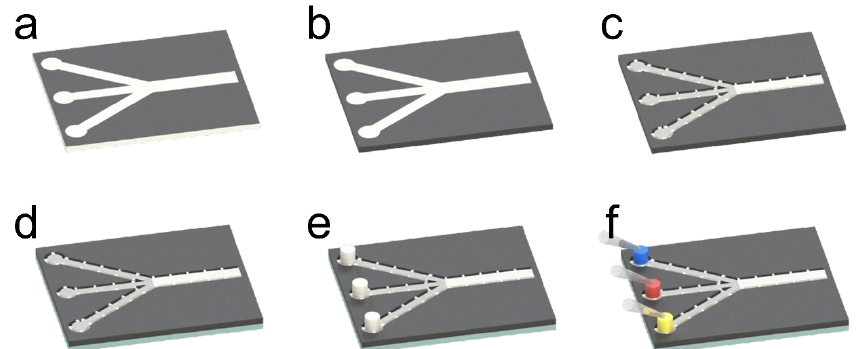
Figure A3. Fabrication process flow for demonstration device. ( a ) A wax layer defining the channels was printed using a solid wax printer onto Whatman #1 chromatography paper. ( b ) The wax was melted by placing the paper into an oven at 170 °C for 2 min. ( c ) The paper was etched and the channels were cut to final dimensions. The presence of the side-struts along the edge of the channels are for support, preventing the wet channels from buckling and lifting up from their backing. ( d ) The bottom side of the devices were coated with packing tape to form a backing. ( e ) Rounds of Whatman #17 chromatography paper were used as sample pads to regulate flow into the channels. ( f ) 100 µL of 5 mM dye was introduced into each channel simultaneously using a multi-channel pipette.